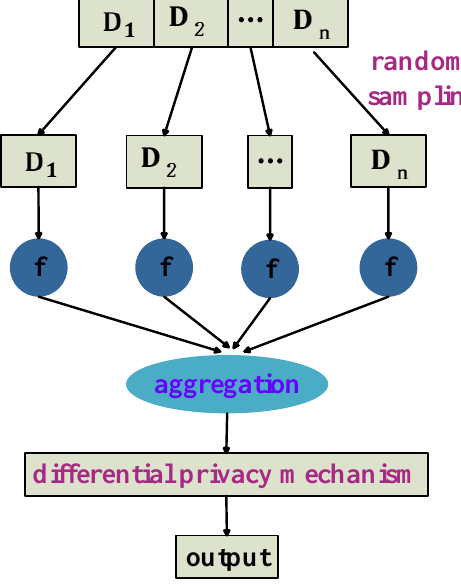
Figure 2. Sample and aggregation